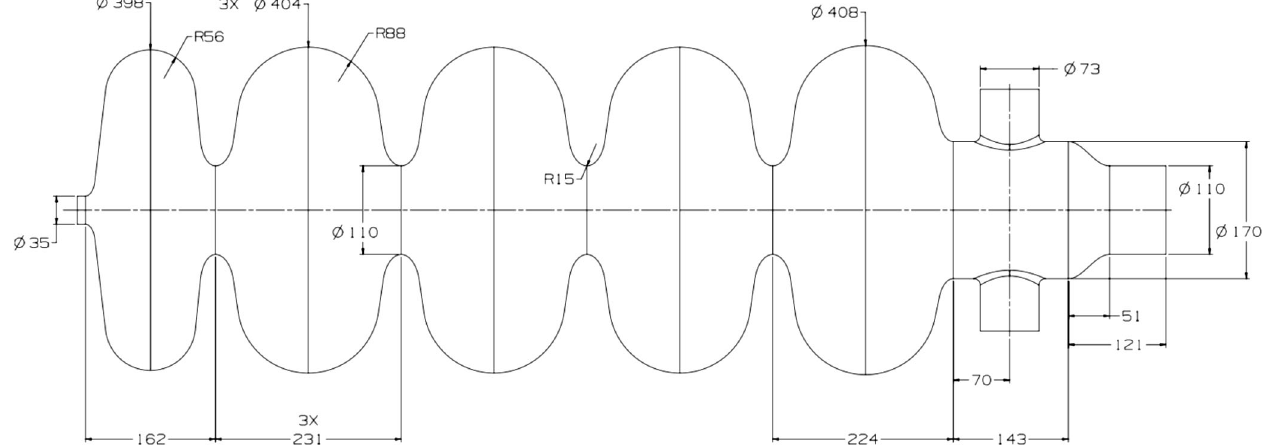
FIG. 7. Geometrical dimensions of the five-cell cavity rf volume. All dimensions are in millimeters.